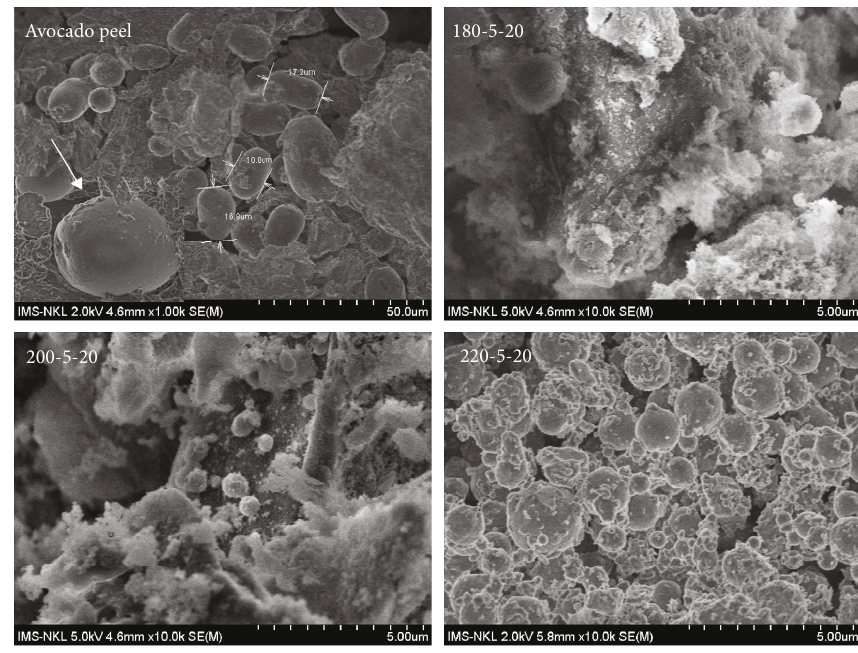
Figure 2: SEM images of feedstock and hydrochars at different